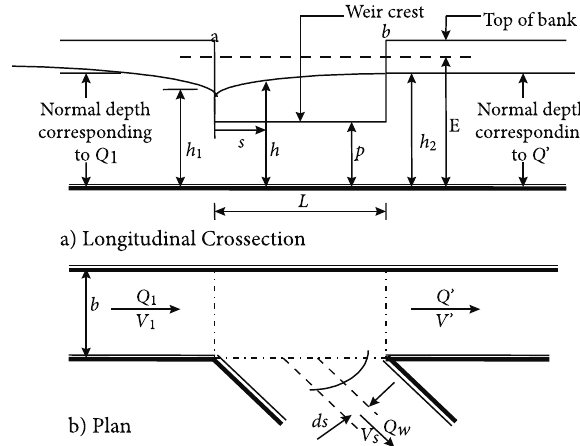
Fig. 1. Definition sketch of subcritical flow over a rectangular